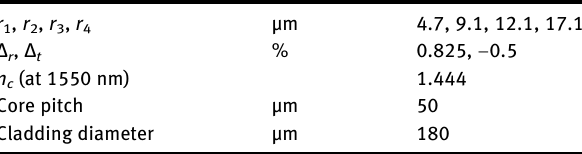
Table  : Structural parameters of designed seven-core RCF.